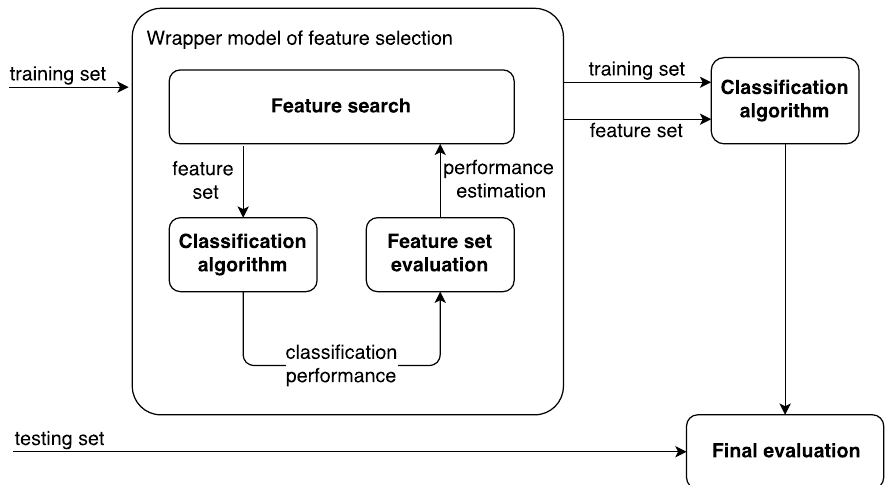
Figure 5. A general framework for wrapper models of feature